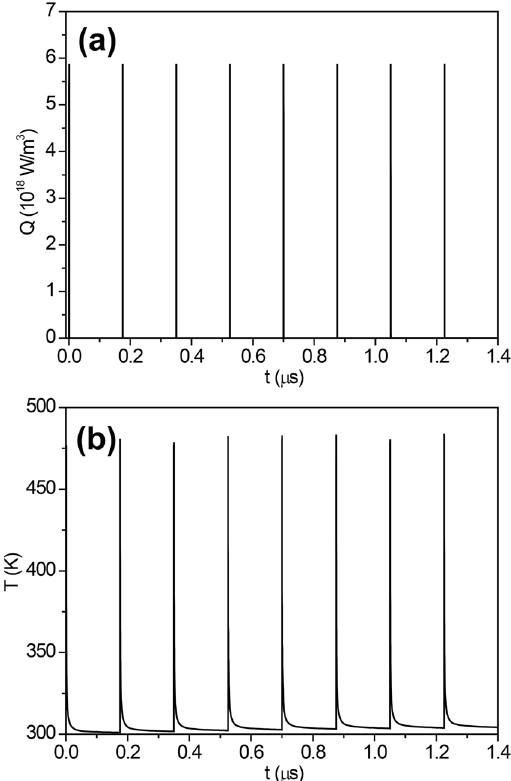
Figure 5. ( a ) Temporal evolution of the heating power density Q at the beam incidence point (the experiment was performed in 16-bunch filling mode). ( b ) Corresponding temporal evolution of the sample temperature calculated at the point of maximum temperature. The initial temperature of the system was set to 300